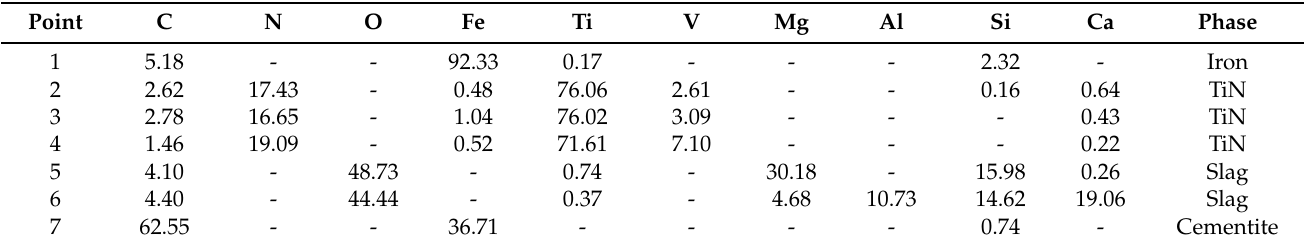
Figure 8. Microstructure and EDS results of the pellets roasted at 1350 ◦ C for 90 min: ( a , b ) typical SEM images; ( c ) metallic iron; ( d ) V, Ti, N, and Fe elemental maps of the area shown in ( b ). Table 7. Elemental composition of points shown in Figure 8